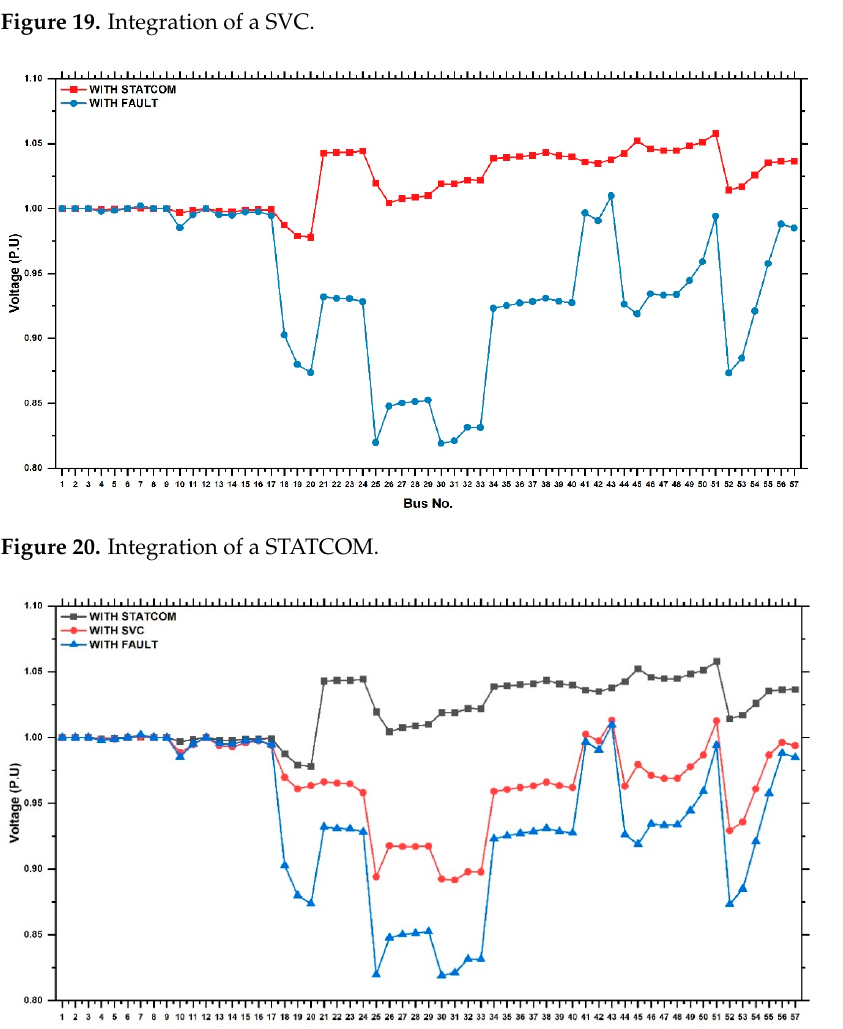
Figure 19. Integration of a SVC.